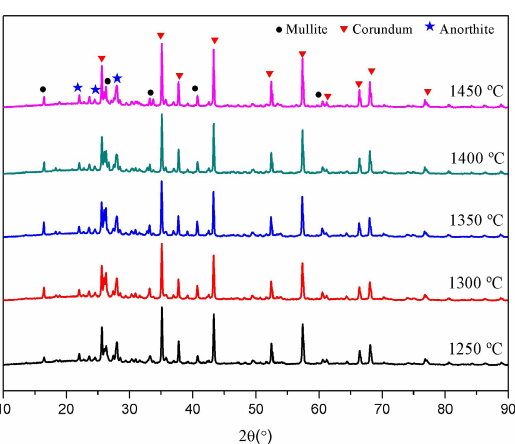
Figure 2. XRD patterns of the specimens sintered at different